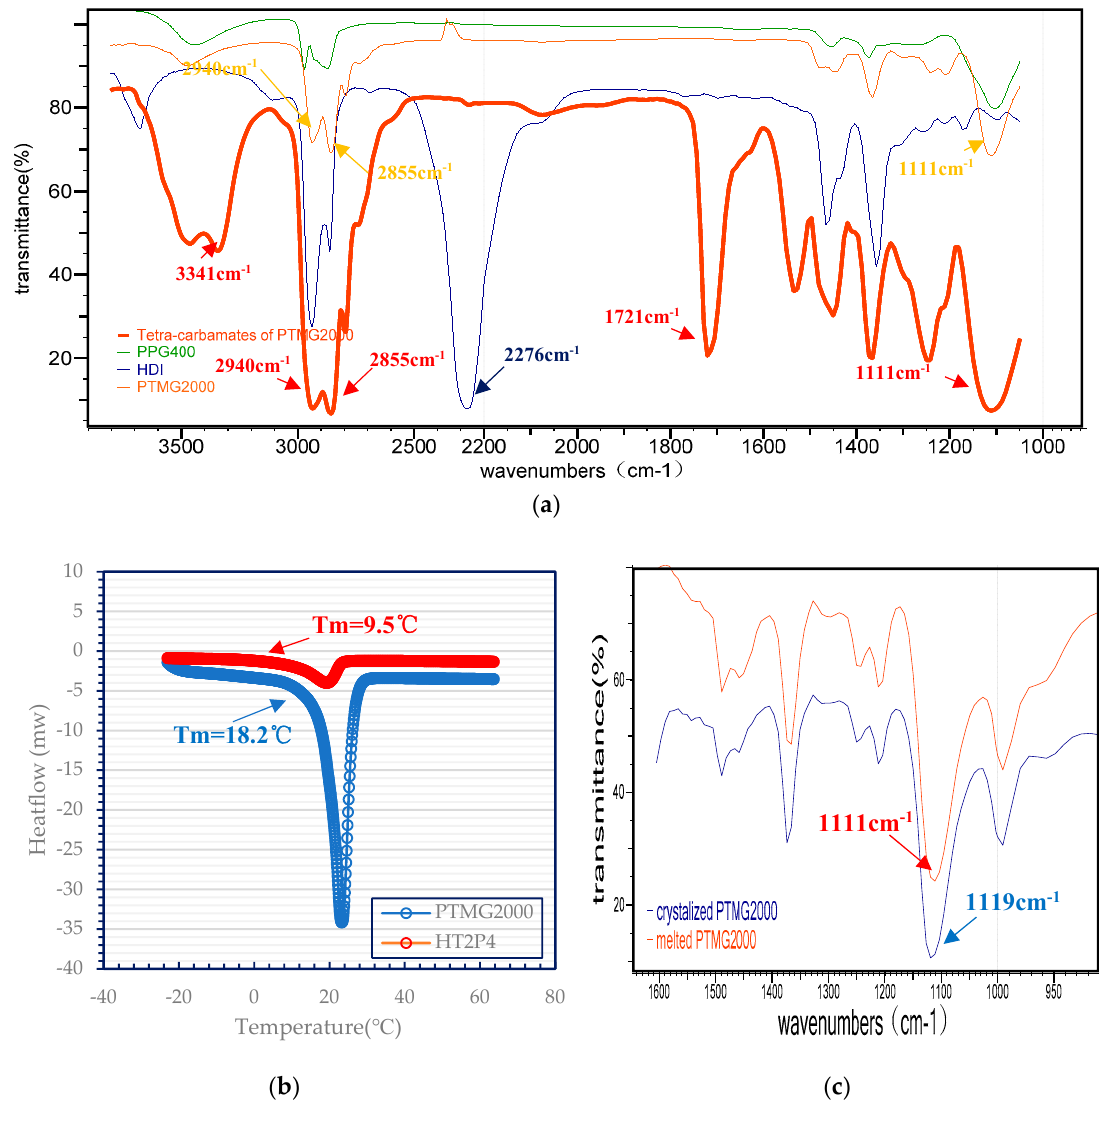
Figure 2. ( a ) FT-IR spectra of HDI, PTMG2000, PPG400 and HT2P4 at 25 °C; ( b ) DSC profile of PTMG2000 and HT2P4; ( c ) FT-IR spectra of crystalized PTMG2000 and melted PTMG2000, respectively.